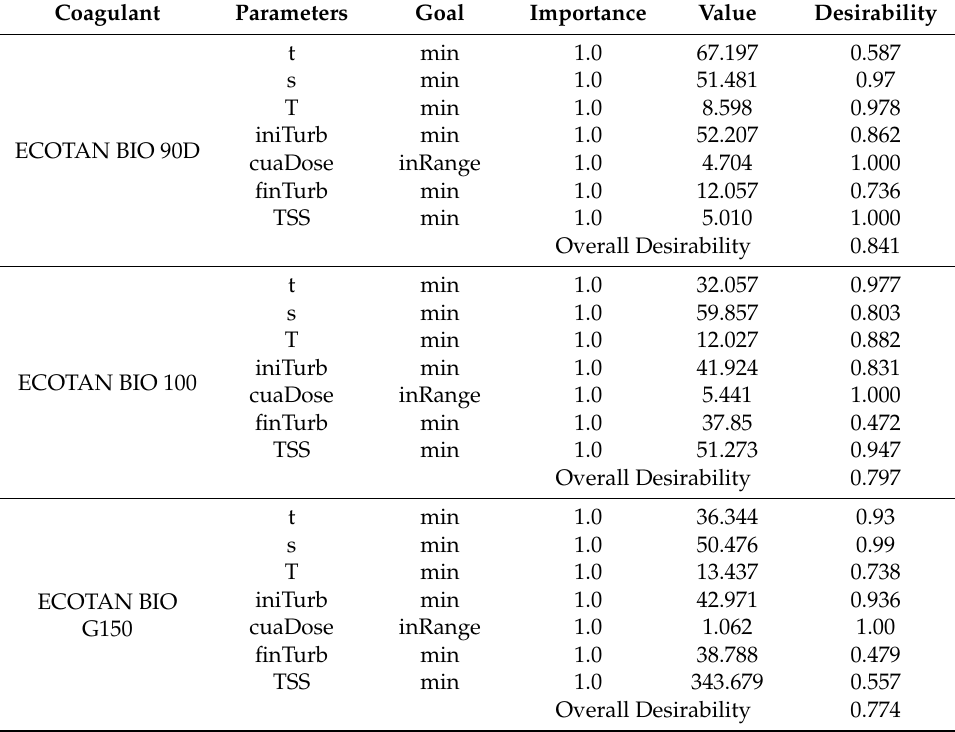
Table 14. The first clarification optimization scenario: all variables are considered to be equally important.